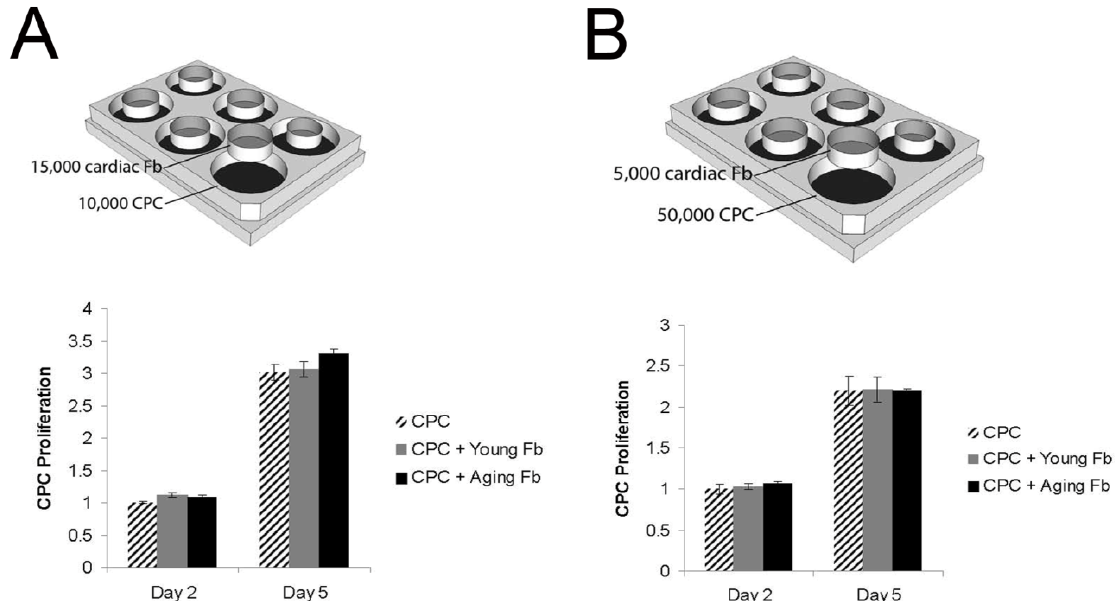
Figure 4. Proliferation of Sca-1 + /CD45 − cardiac progenitor cells at low ( A ) and high ( B ) seeding density. 1 × 10 4 CPCs were seeded into each well and 1.5 × 10 4 cardiac fibroblasts were seeded into each insert ( A ). There was no difference in CPC proliferation when cultured with young or aging fibroblasts compared to cell free medium ( n = 4 per group). To exclude an effect of cell density, we repeated the experiment with 5 × 10 4 CPCs seeded into each well and 5 × 10 3 cardiac fibroblasts seeded into each insert ( B ). CPCs proliferated at the same rate regardless of the presence of young or aging fibroblasts ( n = 4 per group). Fb = fibroblasts; CPC = cardiac progenitor